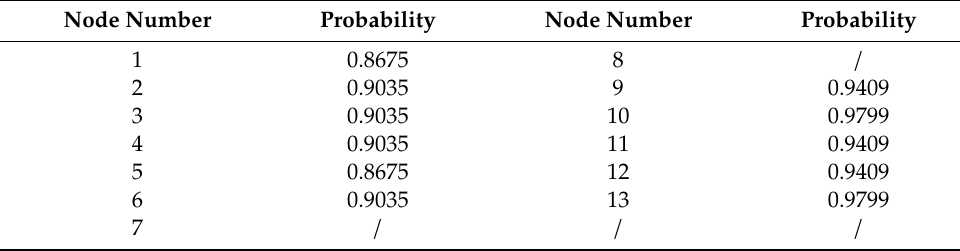
Table A3. The probability that the information received by a node is tampered